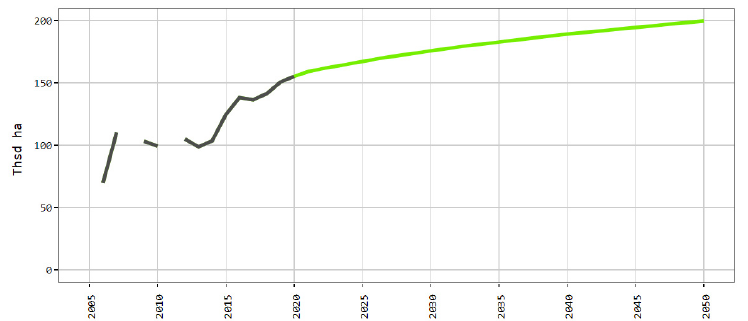
Figure 18. Arable land in organic farming in 2005–2020, with a 2021–2050 projection for Latvia, in thousands of hectares